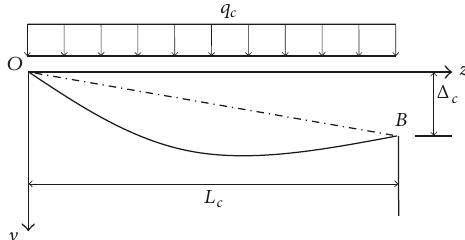
Figure 2: Diagram of evenly distributed vertical loadings along the span of the transmission